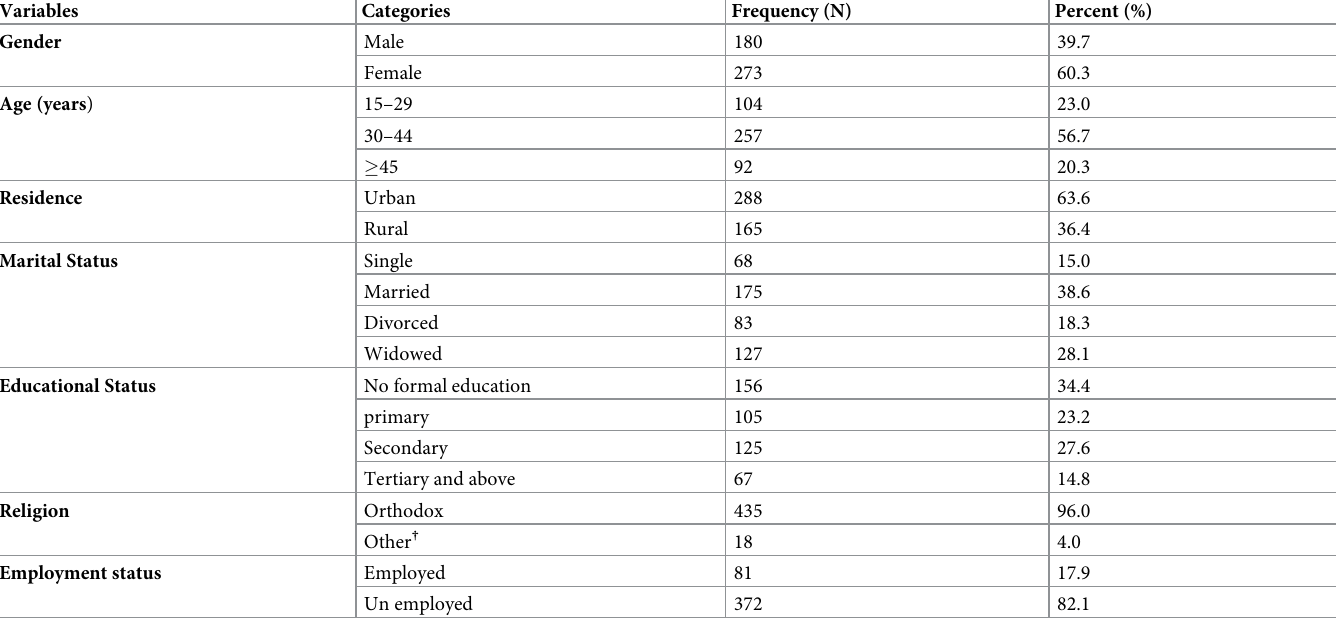
Table 2. Socio-demographic characteristics of participants who were treated with RUTF at Debre Markos Referral Hospital from July of 1 st , 2015 –December of 31 st ,